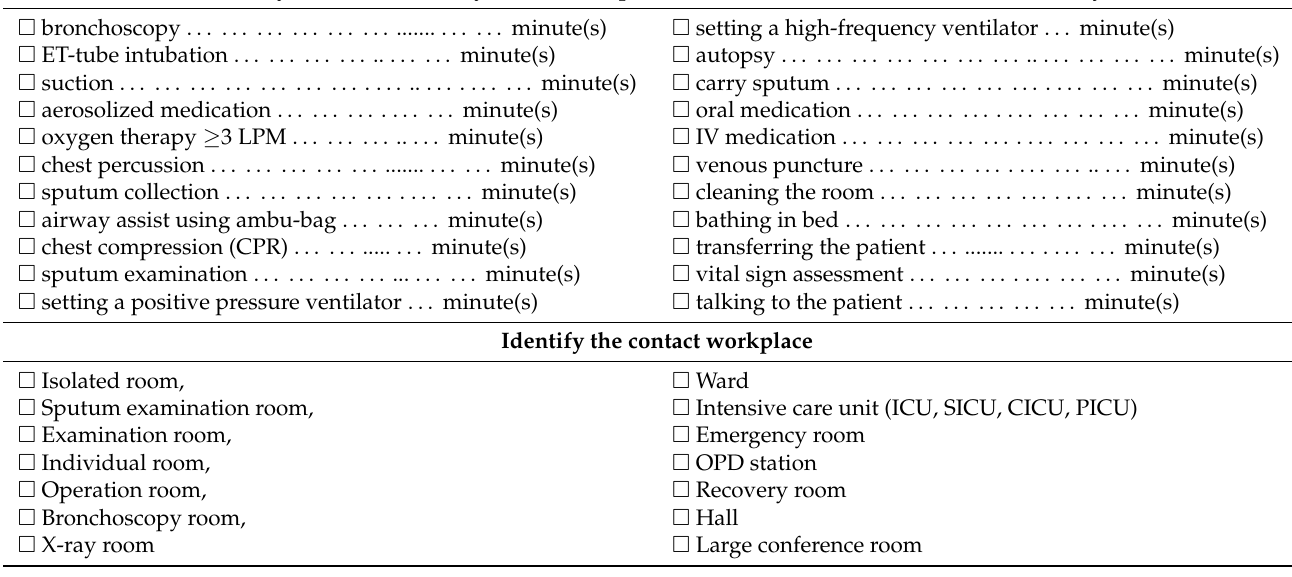
Table A1. Cont. Identify the contact activity with the TB patient and the contact duration of each activity.